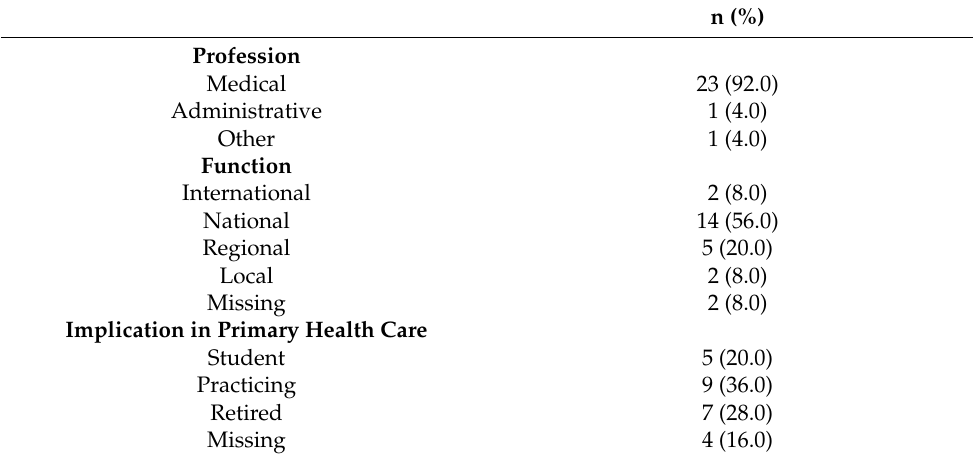
Table 1. Baseline characteristics of participants (N = 25) participants of the study to describe the role of the Tunisian Primary Health Care in the management of the COVID-19